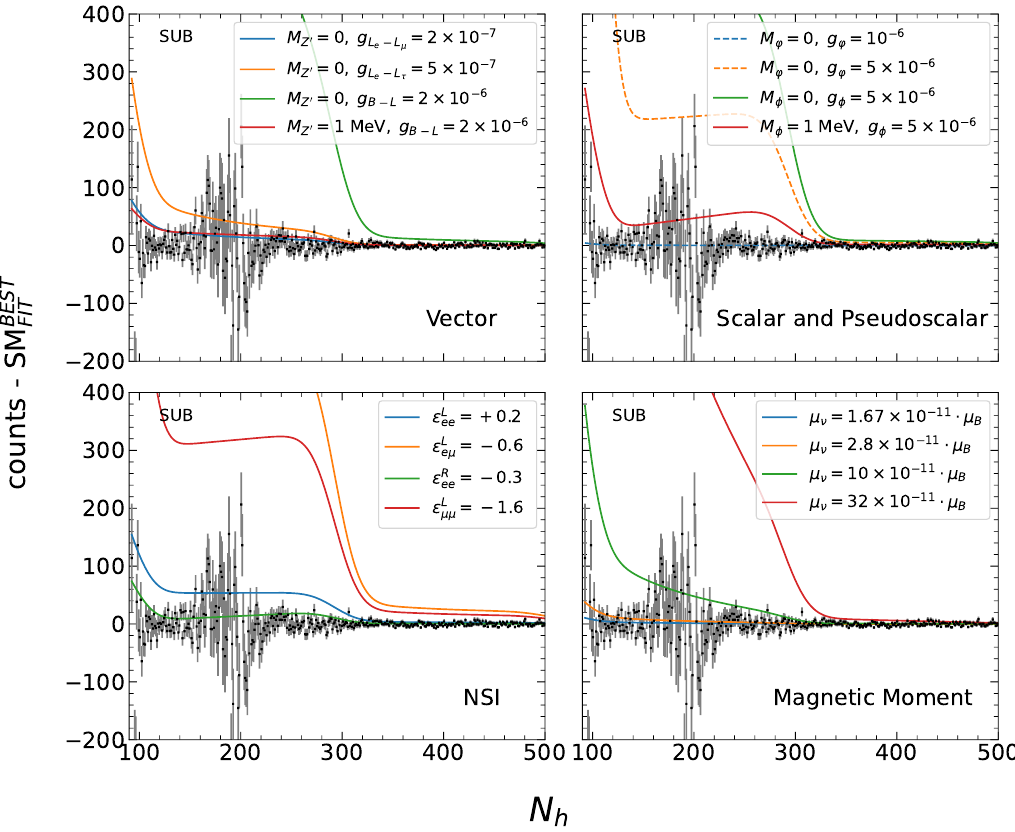
Figure 1 . Difference between the number of events with respect to the SM expectation, as a function of N . For reference, the black dots are obtained for the data in the “subtracted” sample, h where the error bars indicate statistical errors only. The coloured lines correspond to the predicted event rates (using the same exposure as that of the “subtracted” sample) for different BSM scenarios and parameter values, as indicated by the